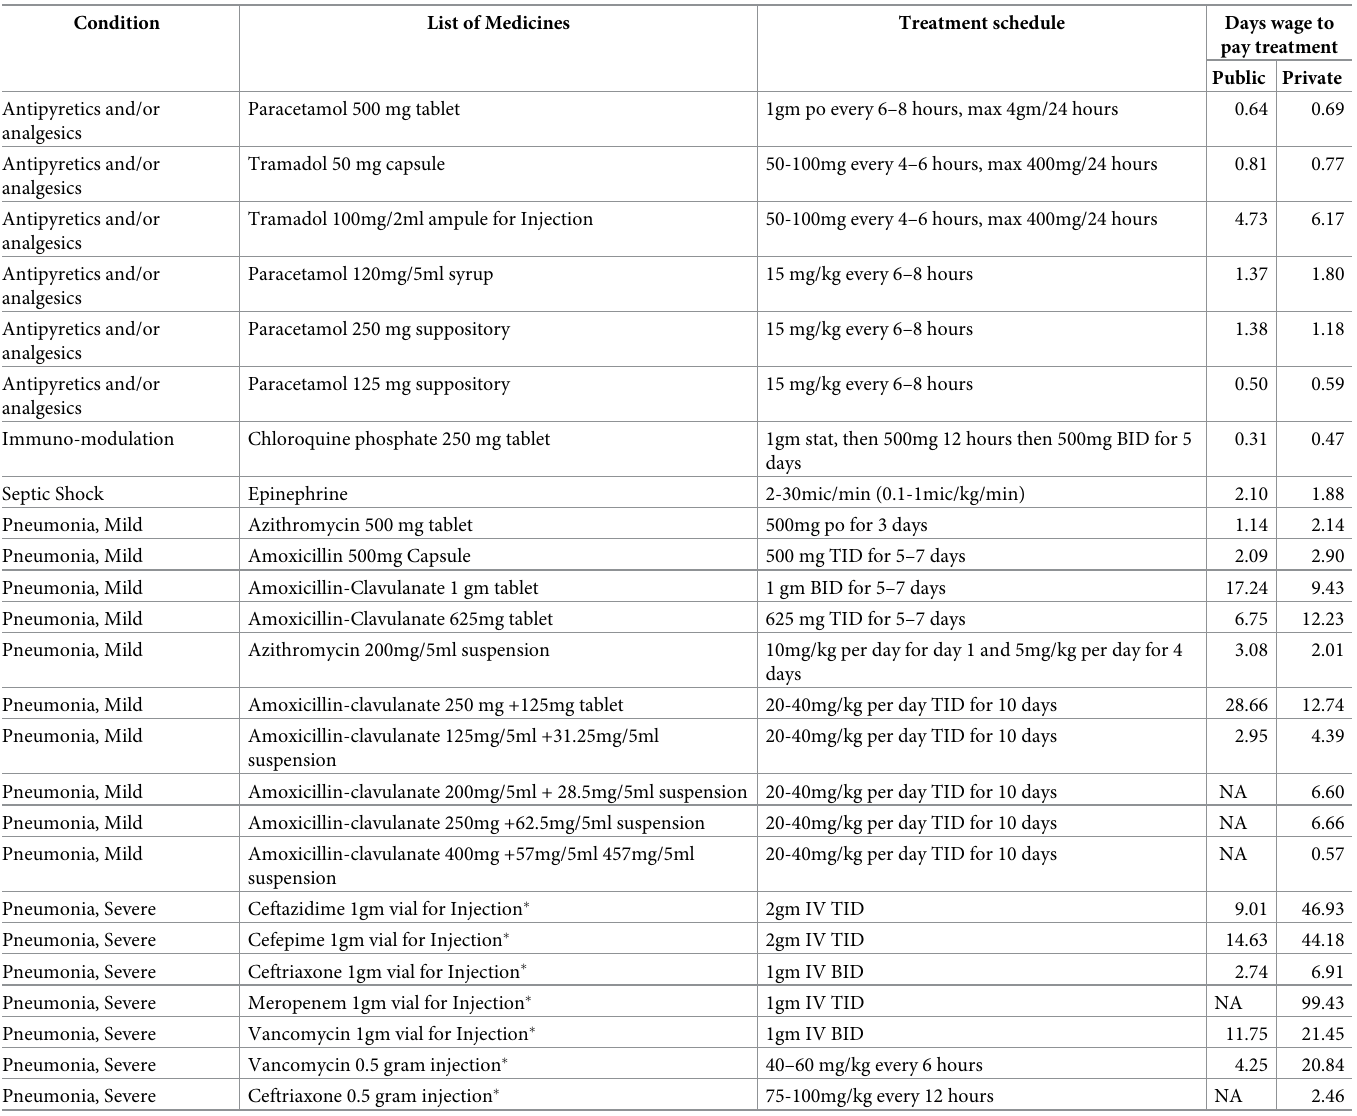
Table 5. Affordability of medicines in health facilities of Dessie town, 2021.